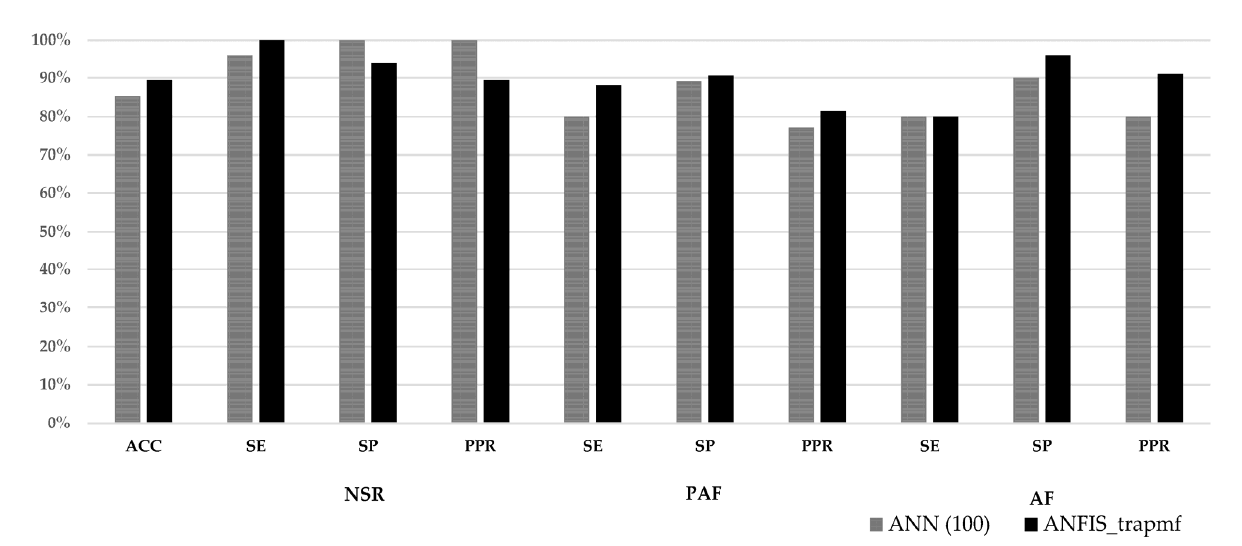
Figure 7. The performance values of the best models of the ANN and ANFIS.